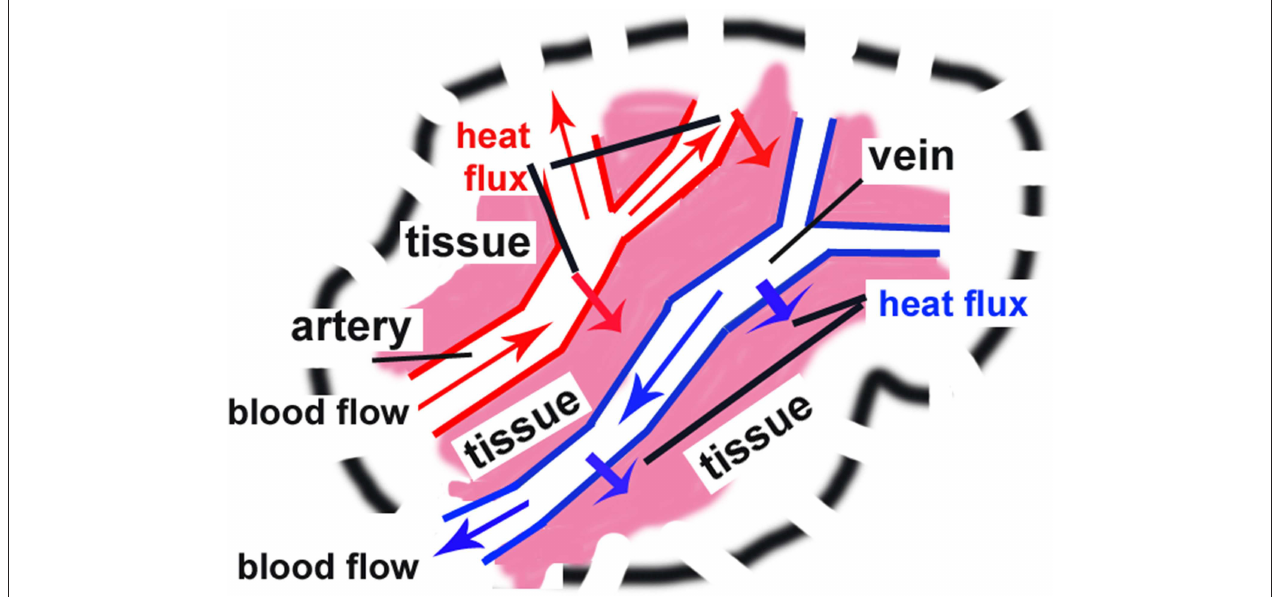
FIGURE 5 | Blood bleed-off trough thermally significant parallel blood vessels only. See explanation in text about the works of Weinbaum et al. [46] and Nakayama et al. [52] and the ideas developed by Wissler [51]. Note: The area is subdivided by area of solid A s and area of capillaries A c